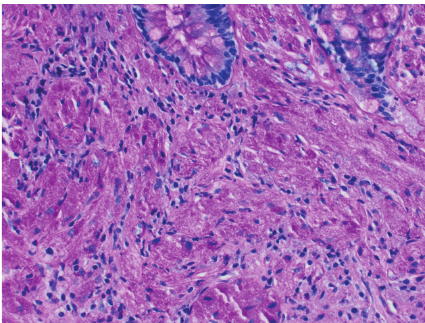
Figure 2: Rectal nodule biopsy (400x) revealing tumor cells arranged in sheets with small round-to-oval nuclei consistent with granular cell tumor on periodic acid-Schiff stain.